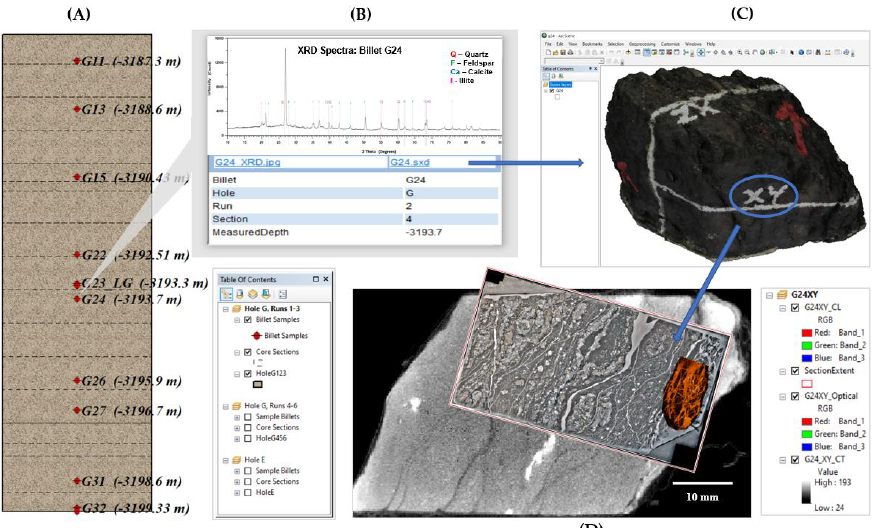
Figure 6. Flow diagram illustrating how project microstructural data are structured, visualized, and explored interactively within the micro-GIS. The figure depicts ( A ) the SAFOD core overview map showing sample billet locations and attributes; ( B ) An example of the HTML pop-up window containing attribute information, results from XRD analysis, and links to additional data associated with sample billet G24; ( C ) the ArcScene workspace containing billet G24′s 3D solid surface model; and ( D ) the spatially referenced 2D image data from a thin section extracted from the XY plane in G24.